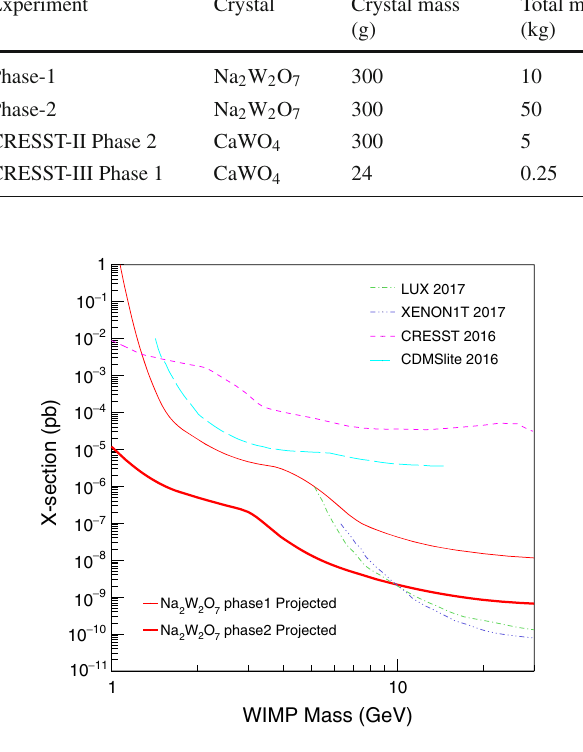
Fig. 10 Expected 90% confidence level limits on the WIMP-nucleon spin-independent (SI) cross section with NWO crystals are pre- sented. Thin red solid line represents a case of 10kg NWO crys- tal, 1 counts/keV/kg/day background, and 1keV energy threshold and thick red solid line corresponds to a case of 50kg crystal, 0.1 counts/keV/kg/day background, and 0.5keV energy threshold